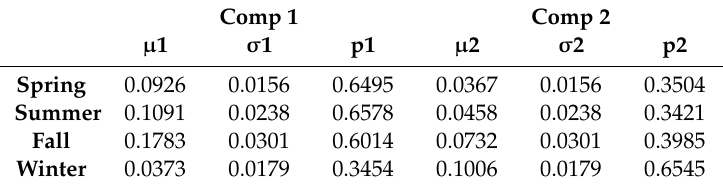
Table 2. Seasonal Gaussian mixture distribution parameters of EVs charging demand.